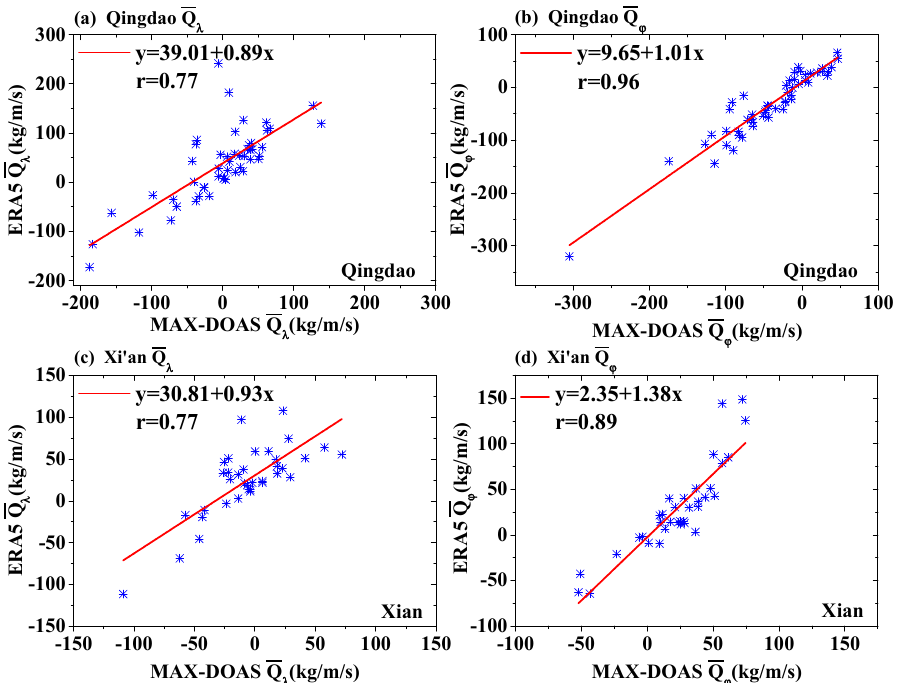
Figure 7. Correlation analysis of MAX-DOAS measurements and ERA5 reanalysis datasets for WVFs: ( a ) the zonal vertically integrated WVF in Qingdao; ( b ) the meridional vertically integrated WVF in Qingdao; ( c ) the zonal vertically integrated WVF in Xi’an; ( d ) the meridional vertically integrated WVF in Xi’an.